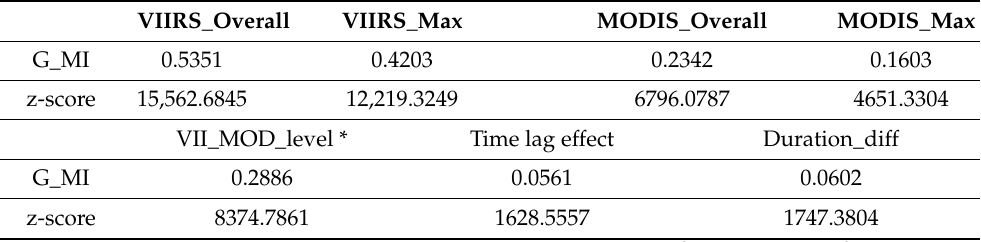
Table 2. Global Moran’s I index (G_MI) and z-score of seven indexes for 11 countries and SEA region, including VIIRS overall trend, VIIRS maximum trend, MODIS overall trend, MODIS maximum trend, VII_MOD_level, Time lag effect, and Duration difference. z-score > 2.58 indicates the 1% significance level.